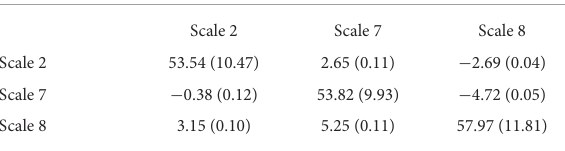
TABLE 3 Difference (normal-schizophrenia) in the imputed MMPI-2 scale in schizophrenia patients and healthy people (Diagonal line shows the mean and standard deviation of randomly generated